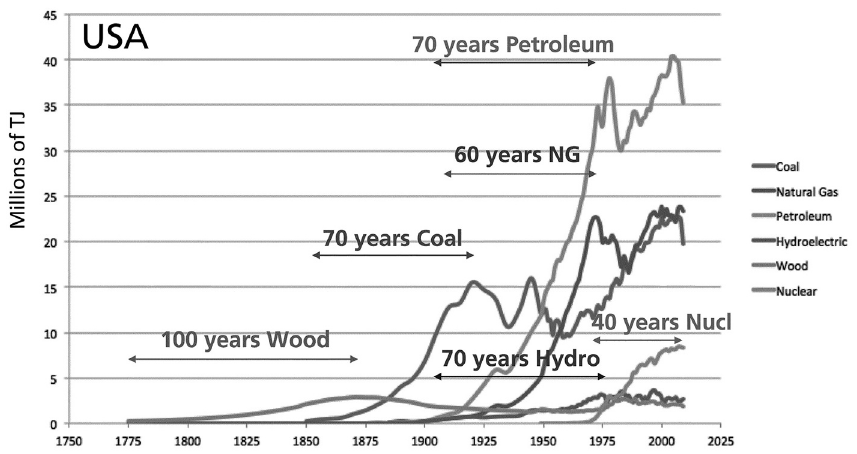
Fig. 2. – Energy consumed by source in the